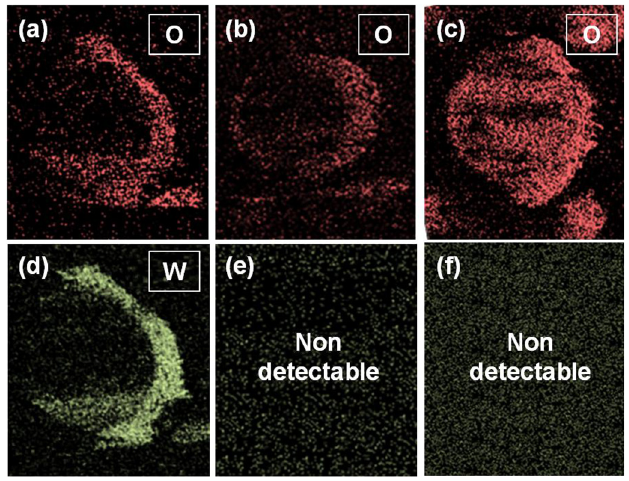
Fig. 7. EDS mapping images for the detection of oxygen (O) at wear tracks of counterpart SUJ2 balls after BOD friction test with different texture diameters of 50 m m (a), 100 m m (b), and 150 m m (c) as well as the detection for tungsten (W) (d – f), respectively.